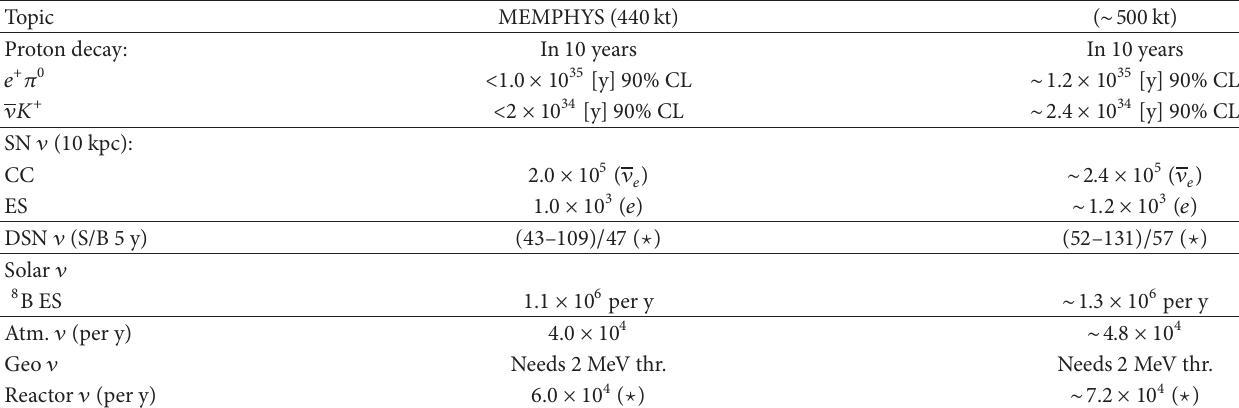
Table 9: Summary of nonaccelerator physics in MEMPHYS.